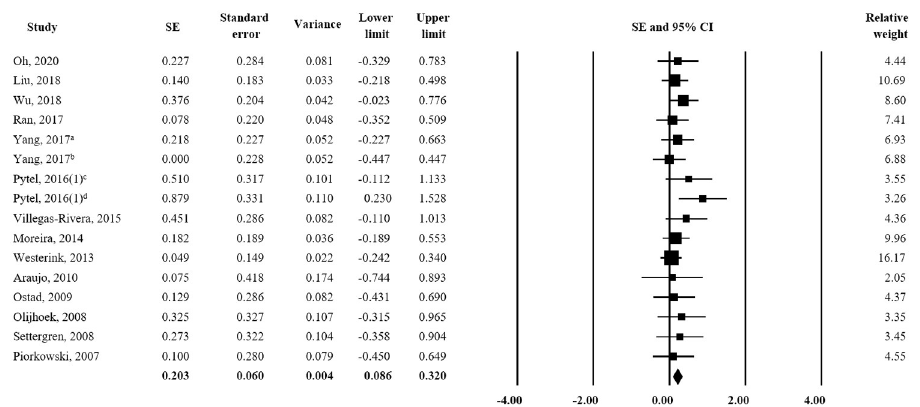
Fig 4. Forest plot of efficacy evaluation results. Changes in Triglyceride observed for high-intensity statin monotherapy and low/moderate-intensity statin plus ezetimibe combination therapy. a rosuvastatin 20 mg vs. rosuvastatin 5 mg plus ezetimibe 10 mg; b rosuvastatin 20 mg vs. rosuvastatin 10 mg plus ezetimibe 10 mg; c rosuvastatin 20 mg vs. atorvastatin 10 mg plus ezetimibe 10 mg; d atorvastatin 40 mg vs. atorvastatin 10 mg plus ezetimibe 10 mg.